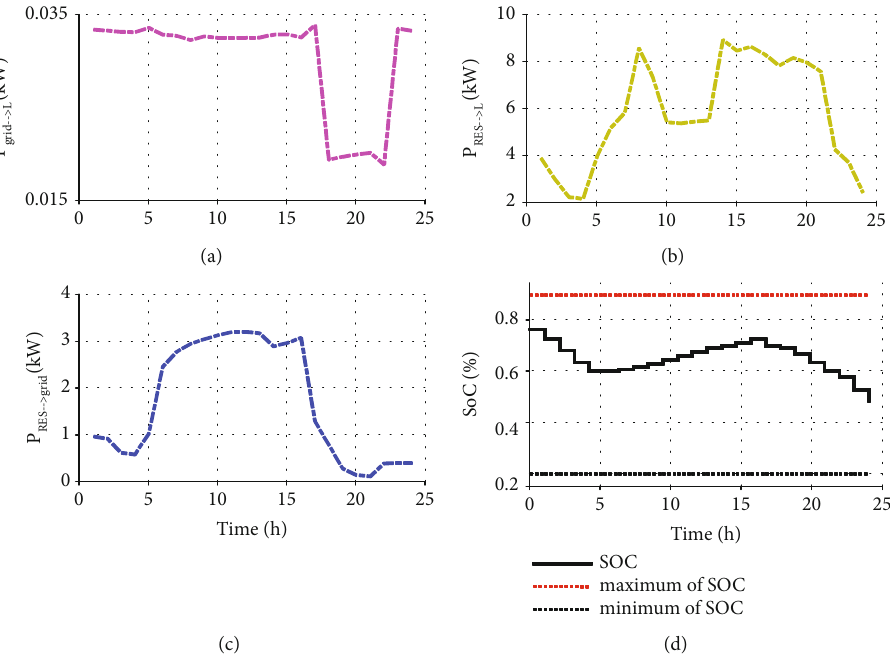
Figure 10: (a) Imported power from the grid to supply the load; (b) generated power from RES to the load; (c, d) RE power injected into the grid and SoC of the battery,